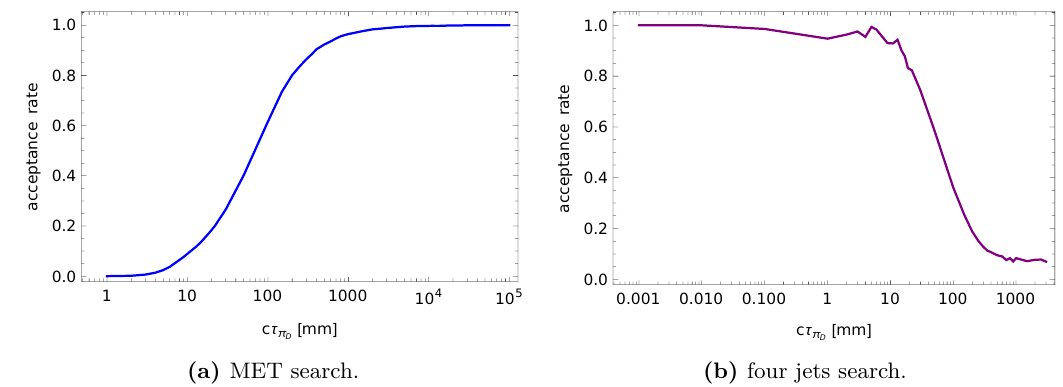
Figure 4. Acceptance rate in the MET search (left) and four jets search (right), depending on the decay length cτ π D